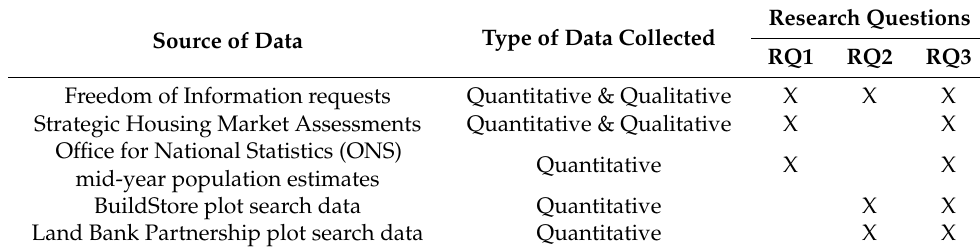
Table 2. Summary of research methods used and corresponding research